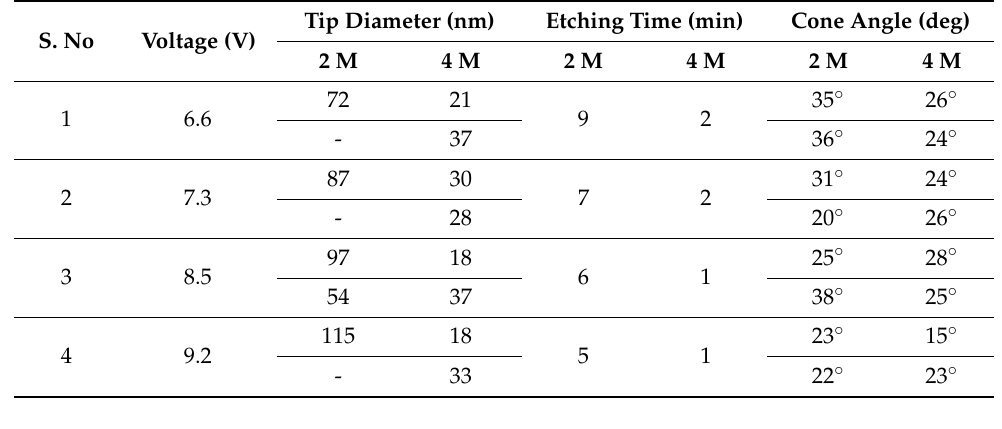
Table 3. Experimental results for 0.4 mm tips showing tip diameter, etching time and cone angle produced in 2 M and 4 M NaOH solution on Meniscus Etching.